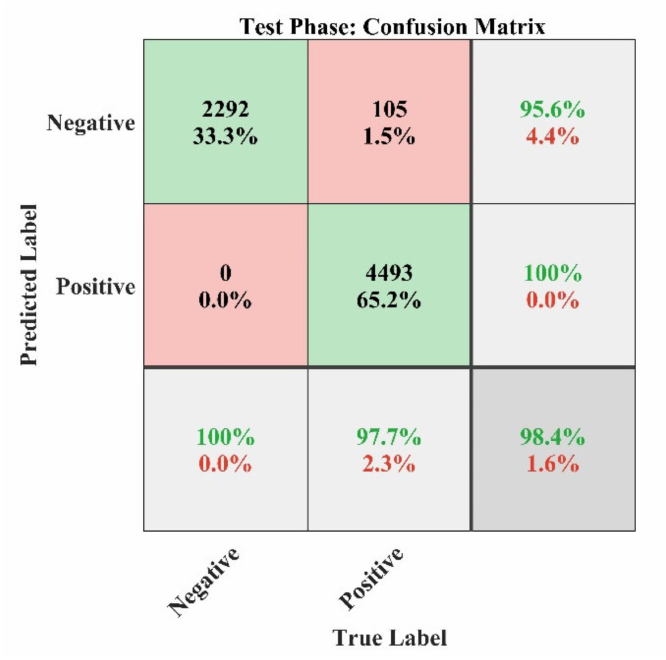
Figure 25. NN confusion matrix analysis plot for the testing phase of the model.